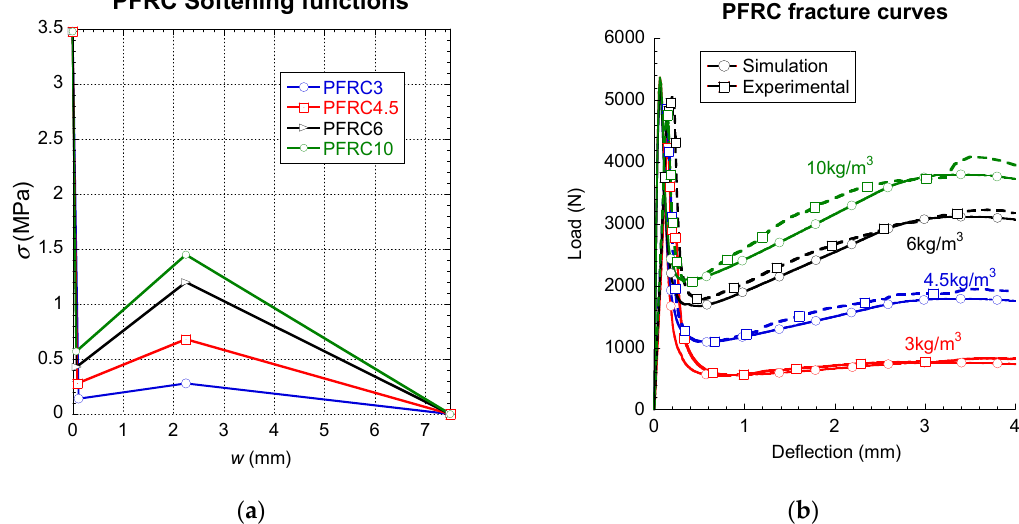
Figure 5. Softening functions ( a ) and comparison among simulated and experimental results ( b ).